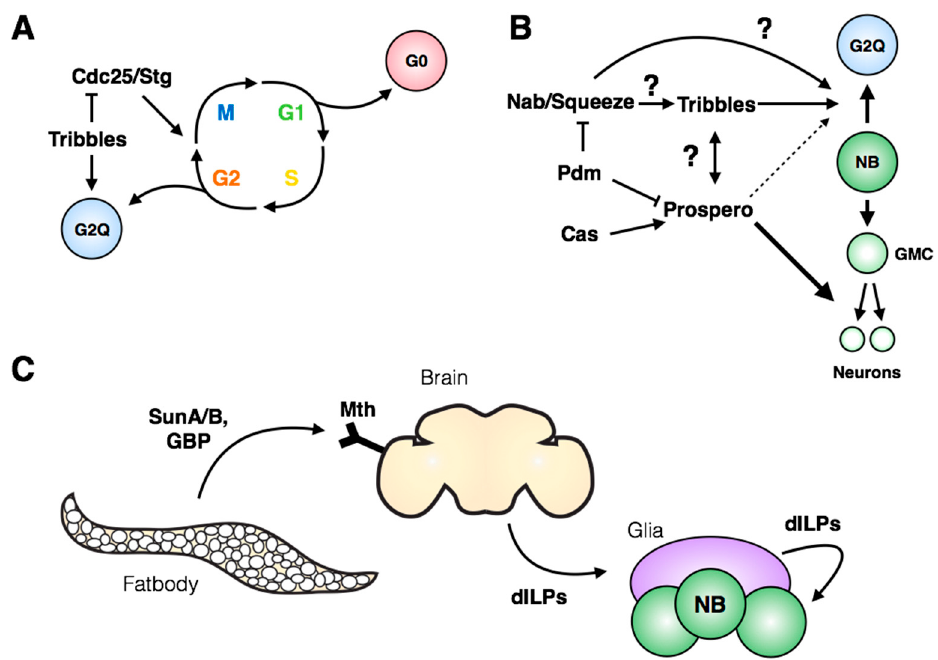
Figure 6. Regulation of neuroblast quiescence and reactivation. ( A ) The majority of post-embryonic neuroblasts exit the cell cycle at G2 phase (G2Q), while the remaining ~25% display a canonical G0 arrest [73]. Tribbles promotes and maintains quiescence through degradation of Cdc25/Stg and inhibition of Akt signaling (not shown). ( B ) Prospero regulates neural differentiation and is required for neuroblast quiescence, but the mechanism underlying its ability to induce two different cell fates is unclear. The connections between G2Q and the Prospero regulatory network are also unknown. ( C ) Secreted factors from the larval fatbody are sensed by the brain, leading to secretion of insulin-like peptides (dILPs). dILPs are also expressed by stellate surface glia, and these act on the neuroblast to promote growth and proliferation.